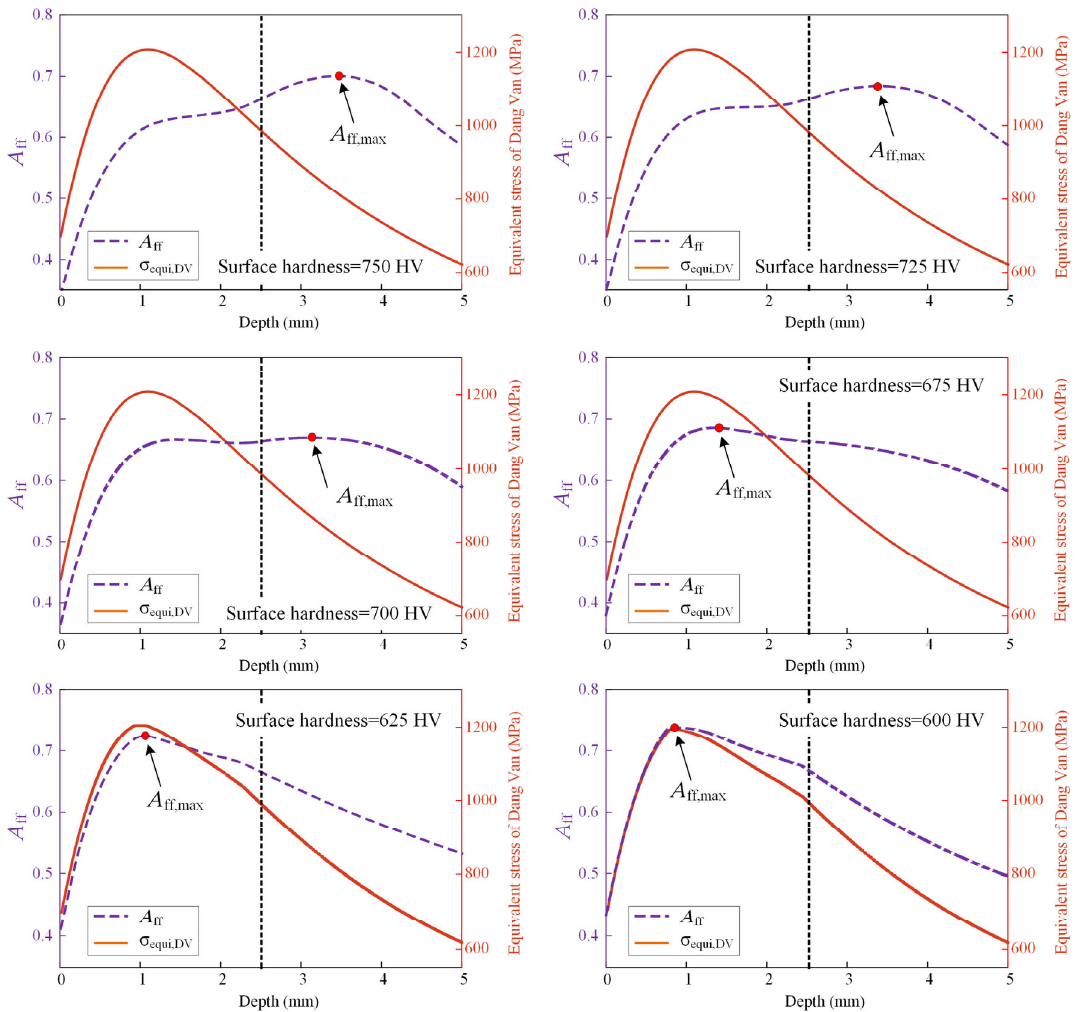
Fig. 11 Equivalent stress and